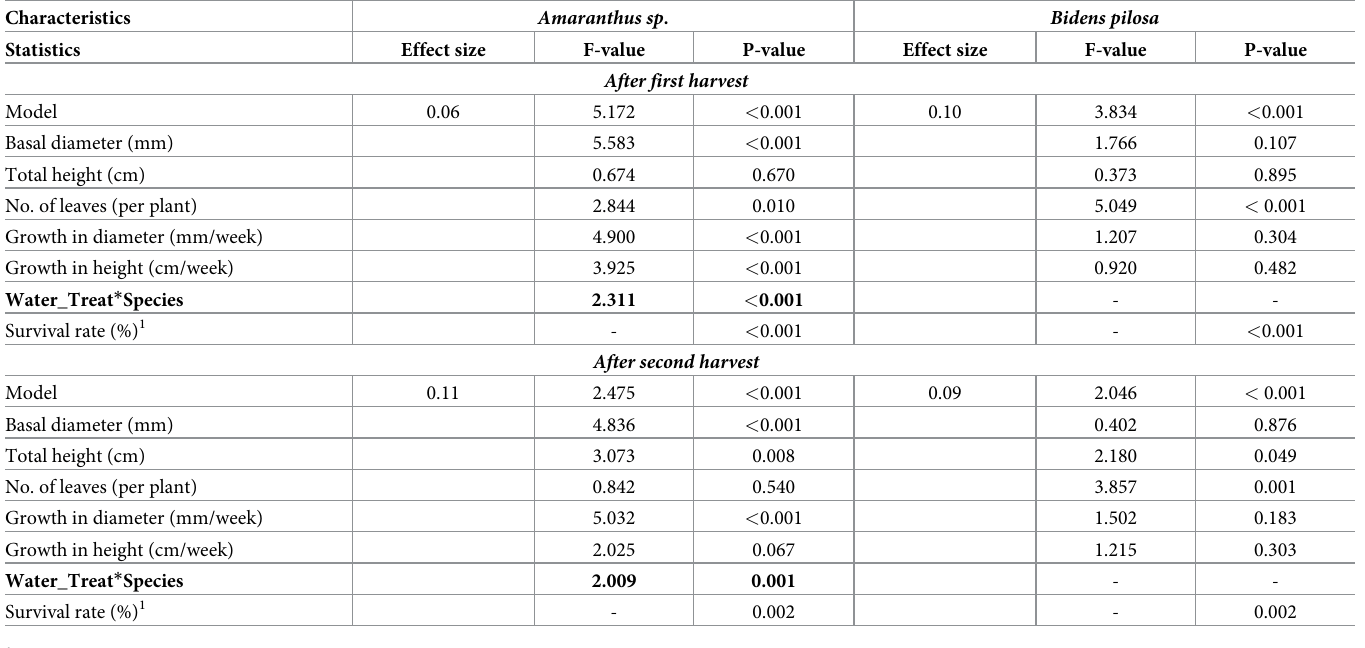
Table 1. Results of the Multivariate Analysis of Variance and log-linear analysis for the impact of water treatment on the study species. Characteristics Amaranthus sp . Bidens